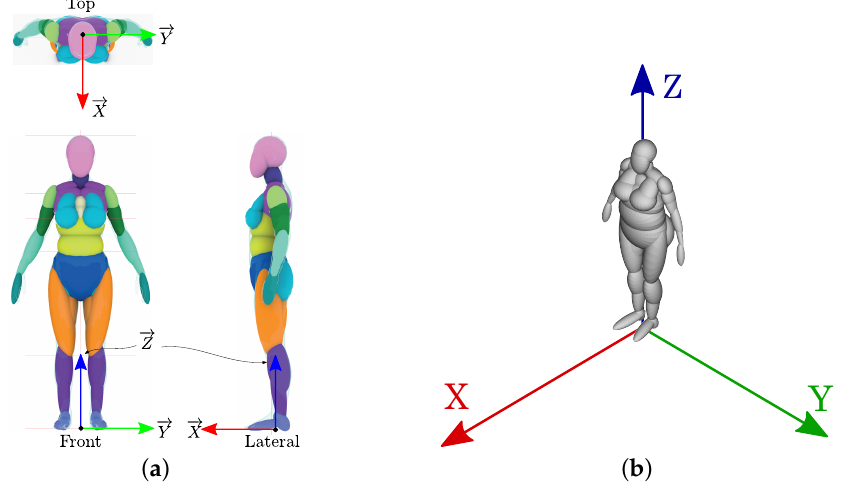
Figure 11. World Coordinate System definition, registration process, and definition of pivot point (origin) of WCS. ( a ) Orthogonal views. ( b ) Isometric